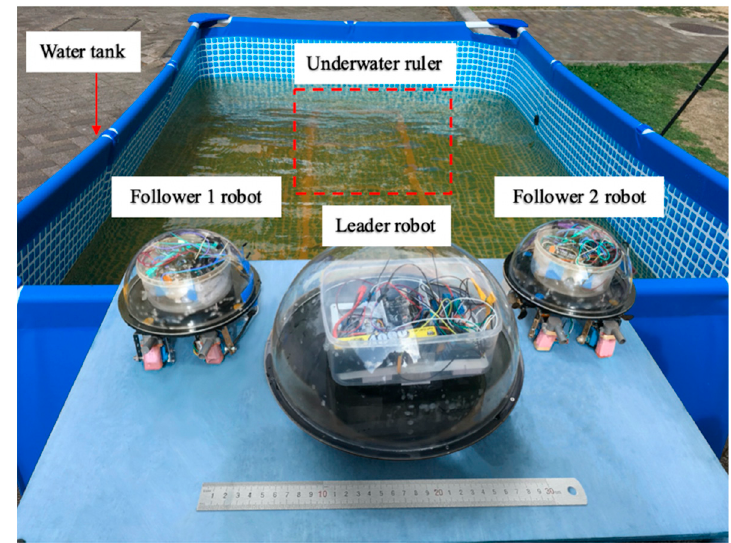
Figure 12. Experimental set up of the multi-robot cooperation.